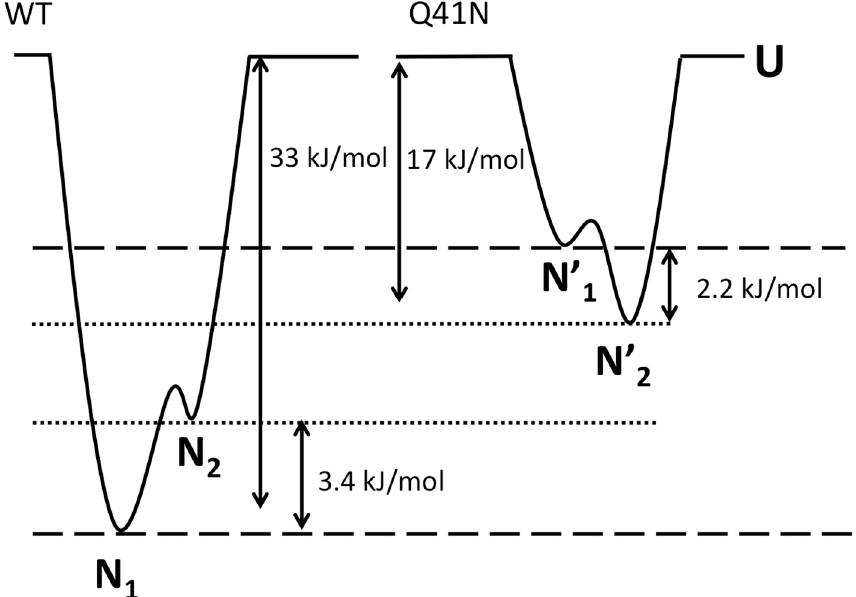
Figure 7. The Gibbs free energy diagrams for the N 1 , N 2 , and unfolded (U) states of WT (left) and Q41N (right) ubiquitin at 298 K. Δ G between N 1 and N 2 for WT and Q41N at 298 K were obtained from the literature [22].